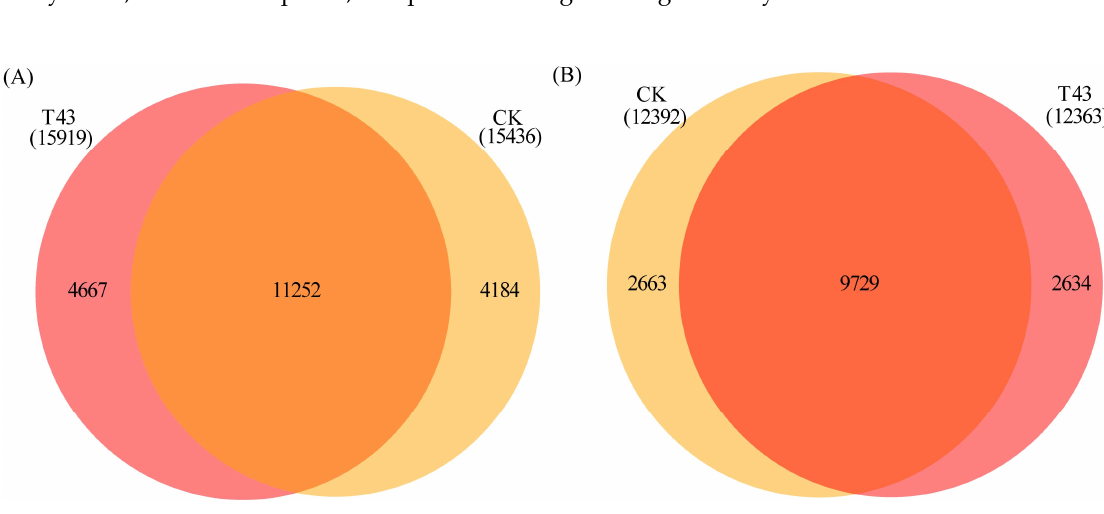
Figure 2. Number of overlapped m 6 A peaks ( A ) and m 6 A peak-containing genes ( B ) in CK and T43 groups.